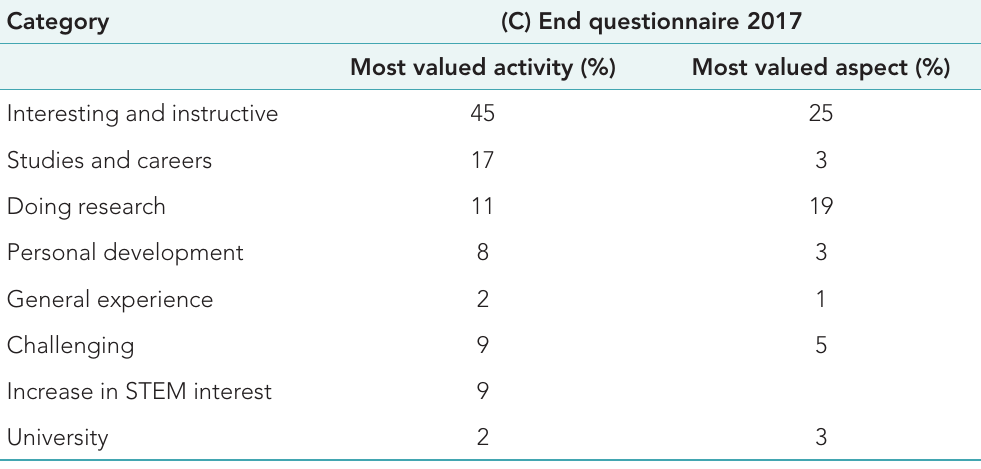
Table 7a: Overview of the percentages of students’ statements relating to their interaction with researchers Category (C) End questionnaire 2017 Most valued activity (%) Most valued aspect (%) Interesting and instructive 45 25 Studies and careers 17 3 Doing research 11 19 Personal development 8 3 General experience 2 1 Challenging 9 5 Increase in STEM interest 9 University 2